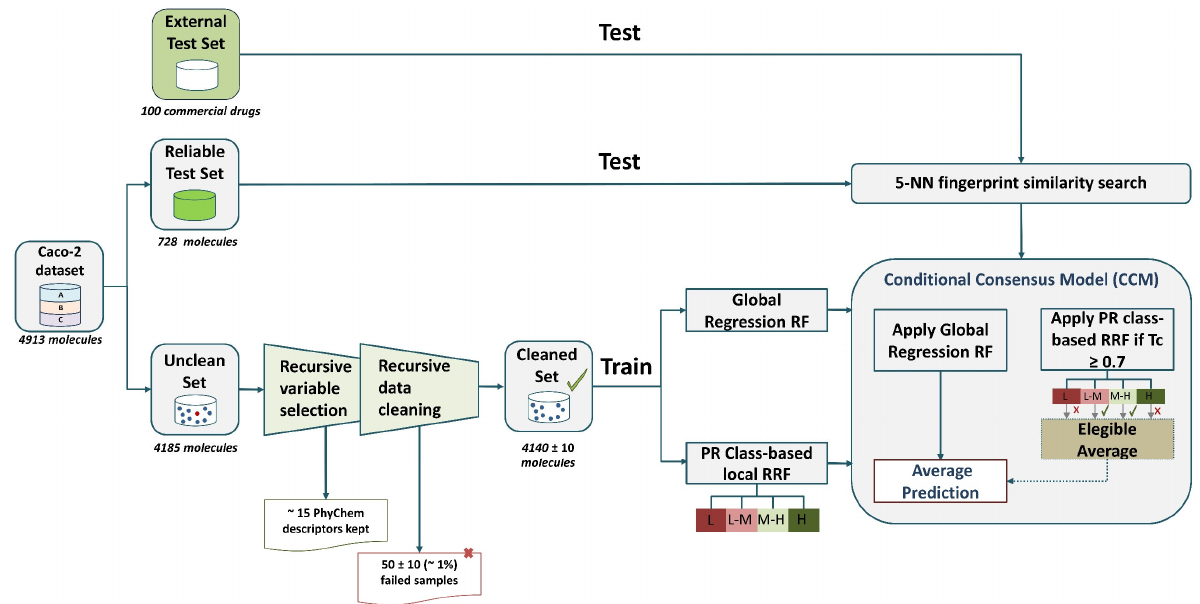
Figure 2. Overview of modeling and validation workflow. L: “low permeability” log P app < 6; L-M: “low–moderate” 6 ≤ log P app < 5; M-H: “moderate–high Permeability” 5 ≤ log P app < 4.7; H: “high permeability” 4.7 ≤ log P app . Tc: Tanimoto coefficient. RF: random forest. PR: permeability region.